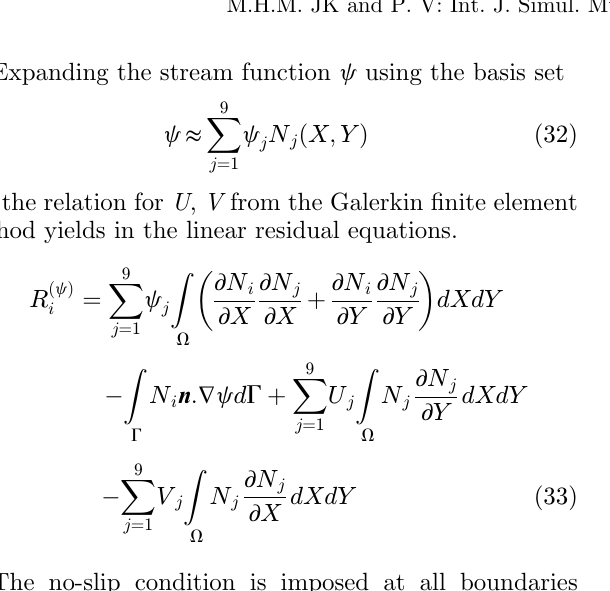
¼ 0 , DA, u = 1, BC, u =0, n